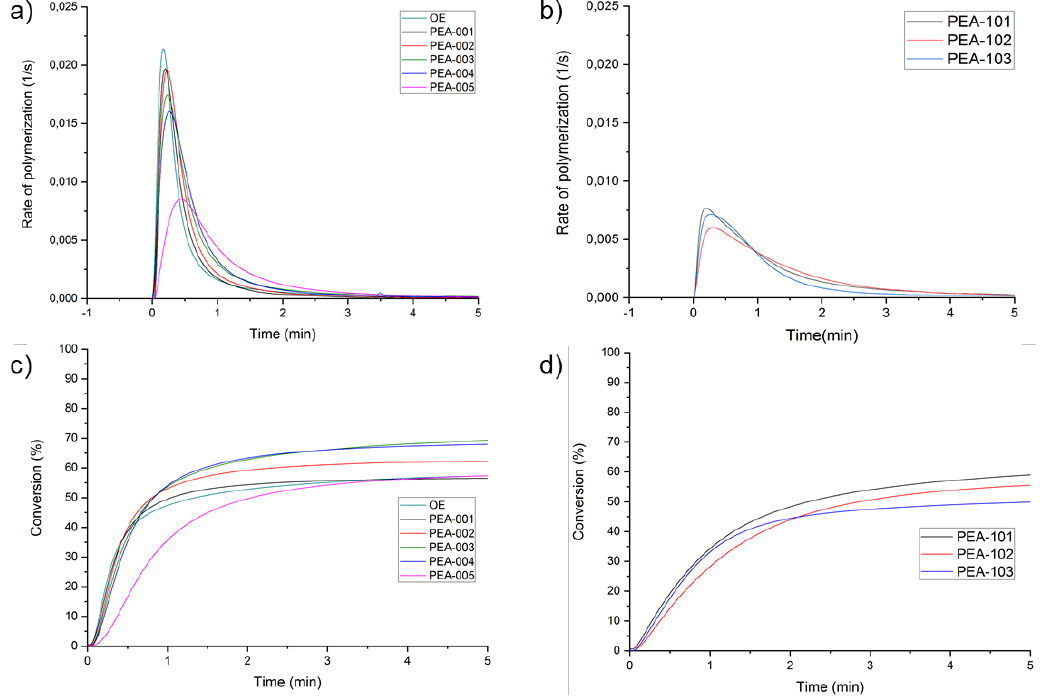
Figure 5. Photo-curing of OE and PEAs. (a) rate of polymerization of PEA-001-005; (b) rate of polymerization of PEA-101-103; (c) free double-bond conversion PEA-001-005; (d) free double-bond conversion PEA-101-103. Table 3. Overview over double bond density, enthalpy, rate of polymerization, and conversion.